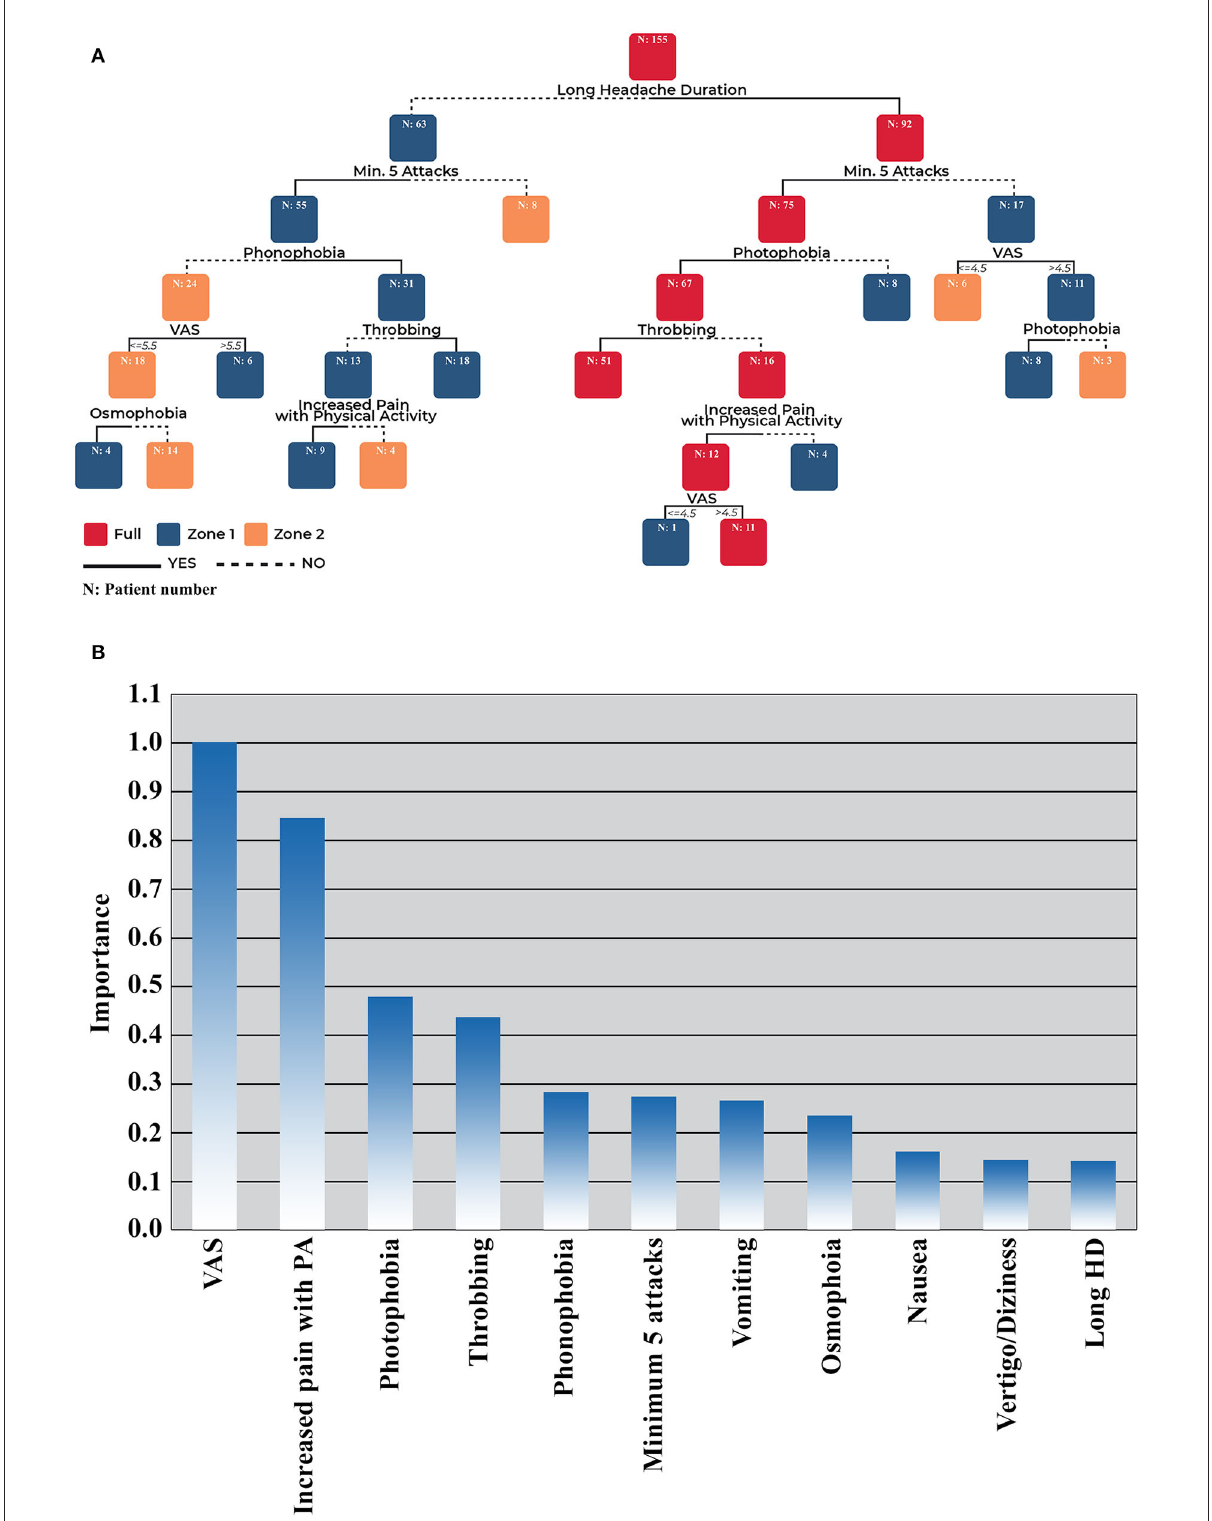
FIGURE2 (A) CART analysis results of patients with I/GE with MwoA in terms of diagnostic criteria relevance*. (B) CART analysis relative variable importance chart. * CART analysis decision tree; from top to bottom. CART, Classification and Regression Tree; HD, headache duration; I/GE, idiopathic/genetic epilepsy; Min, minimum; MwoA, migraine without aura; PA, physical activity; VAS, visual analog